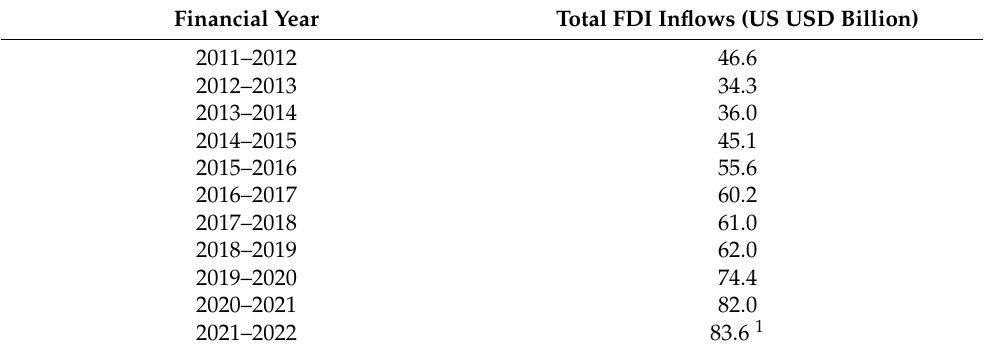
Table 1. Changes in India’s